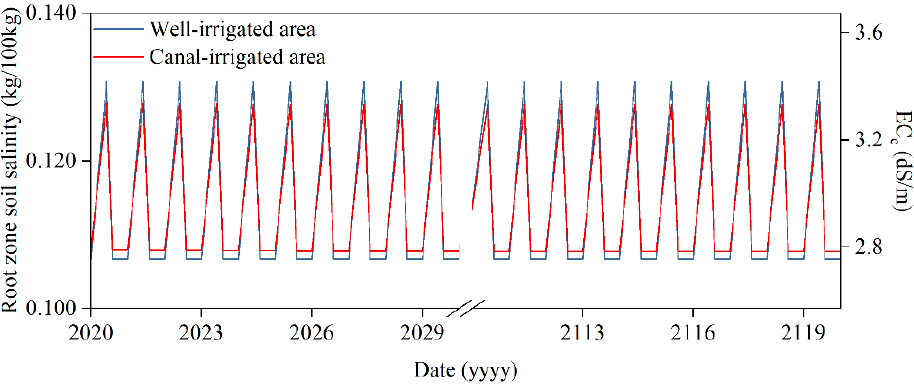
Figure 9. Root zone soil salinity prediction in the future 100 years under current conditions.